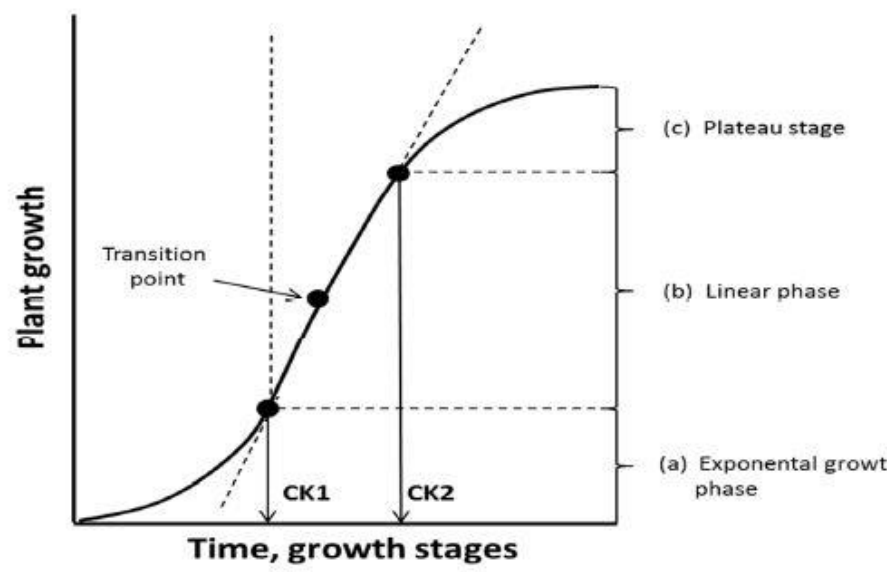
Figure 5. A conceptual pattern of dry matter accumulation by a typical seed/grain crop. Key: CK1, CK2—cardinal stage 1 and 2, respectively [8].